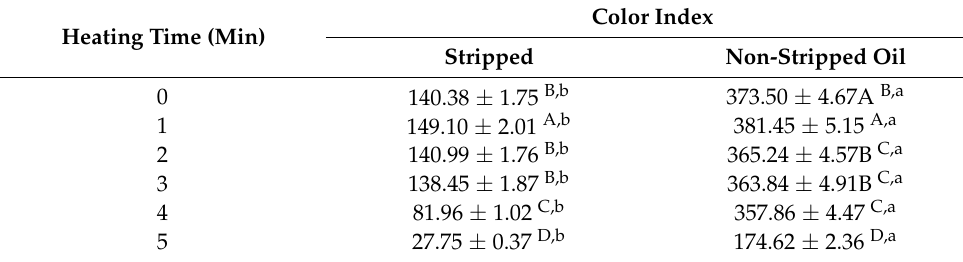
Table 14. Color indexes of stripped and non-stripped linseed oil subjected to microwave heating.